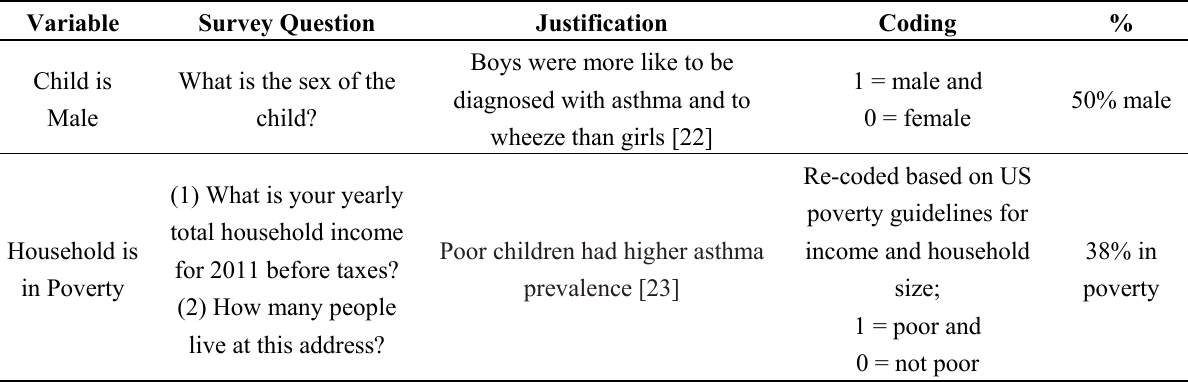
Table 2. Social disparity indicators: survey questions, justification, coding and descriptive statistics.